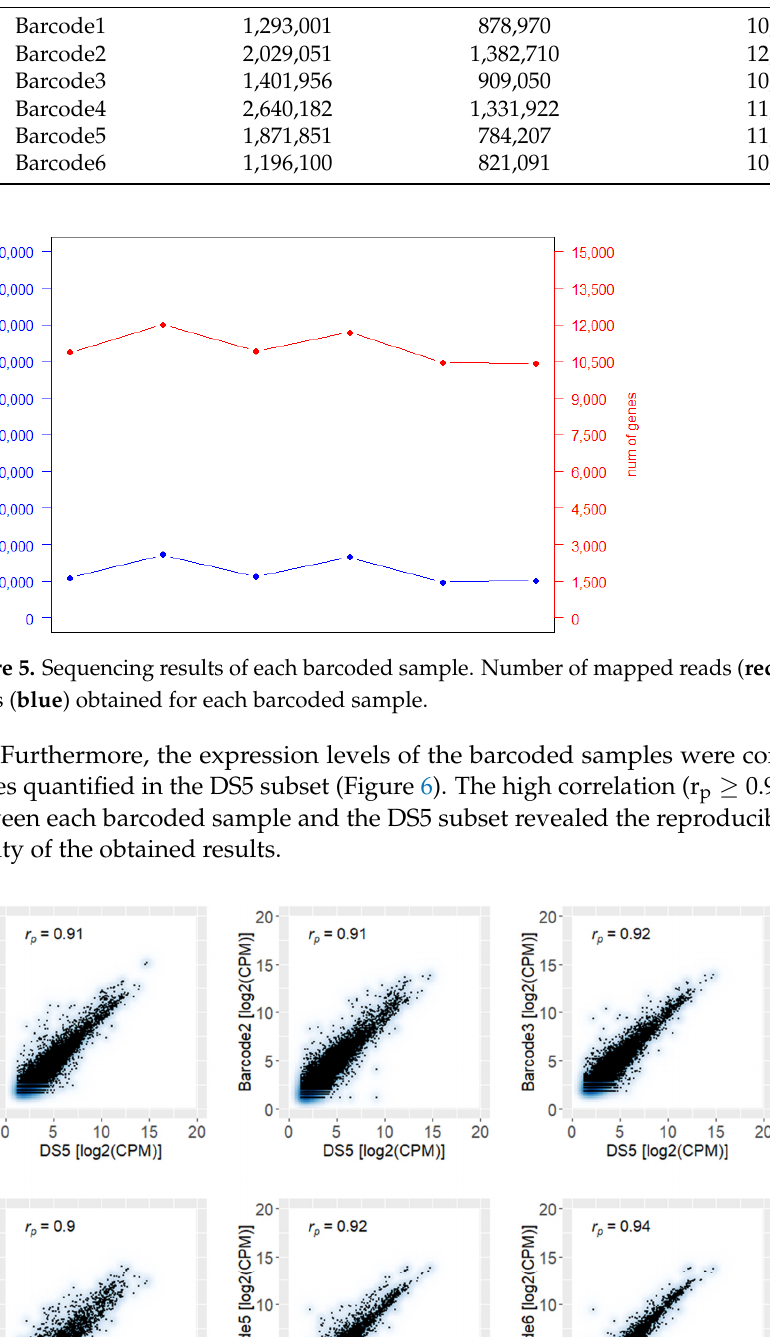
Table 2. Sequencing data of each barcoded sample.